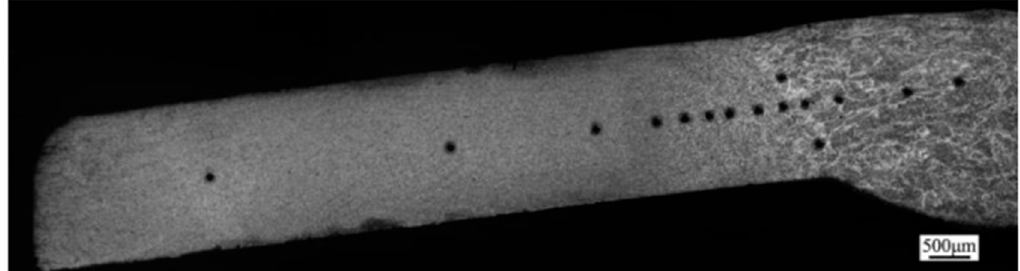
Figure 10. Points selection for micro-hardness test of longitudinal weld.